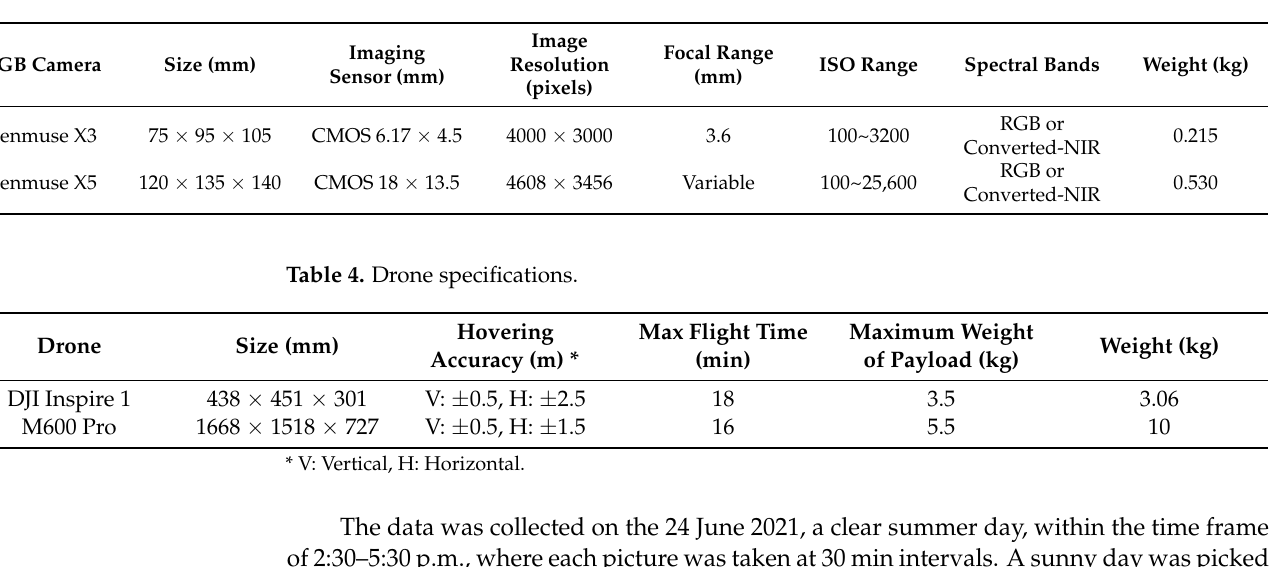
Table 3. RGB cameras specifications.